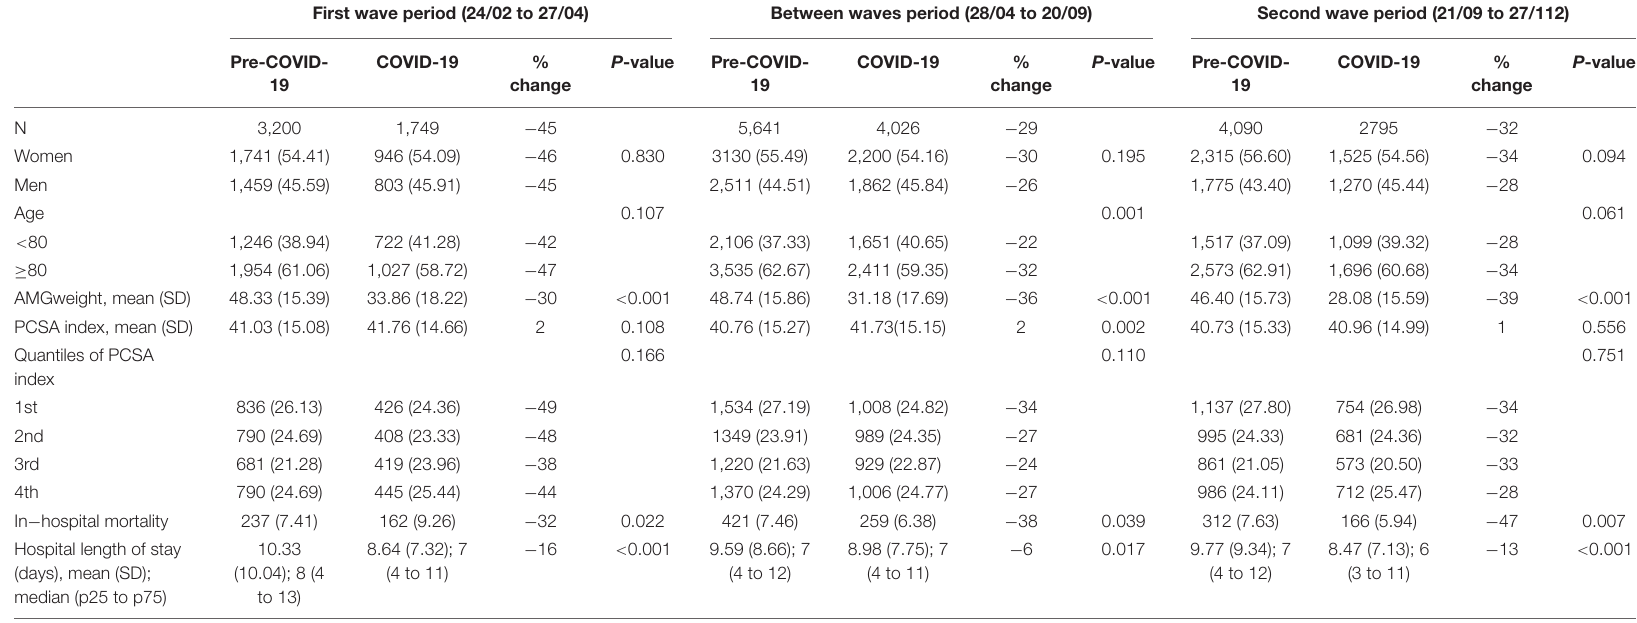
TABLE 2 | Characteristics of patients admitted to hospital for acute heart failure (HF) in each period compared with the reference pre-COVID-19